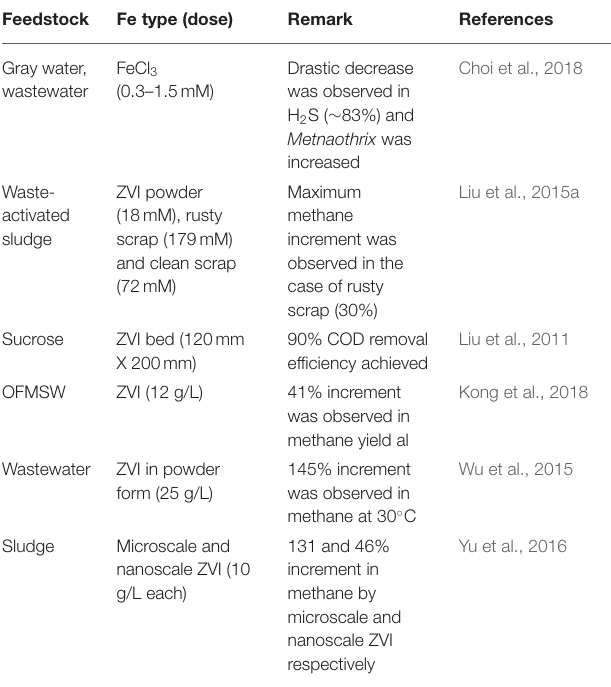
TABLE 4 | Summary of previous studies on application of iron in